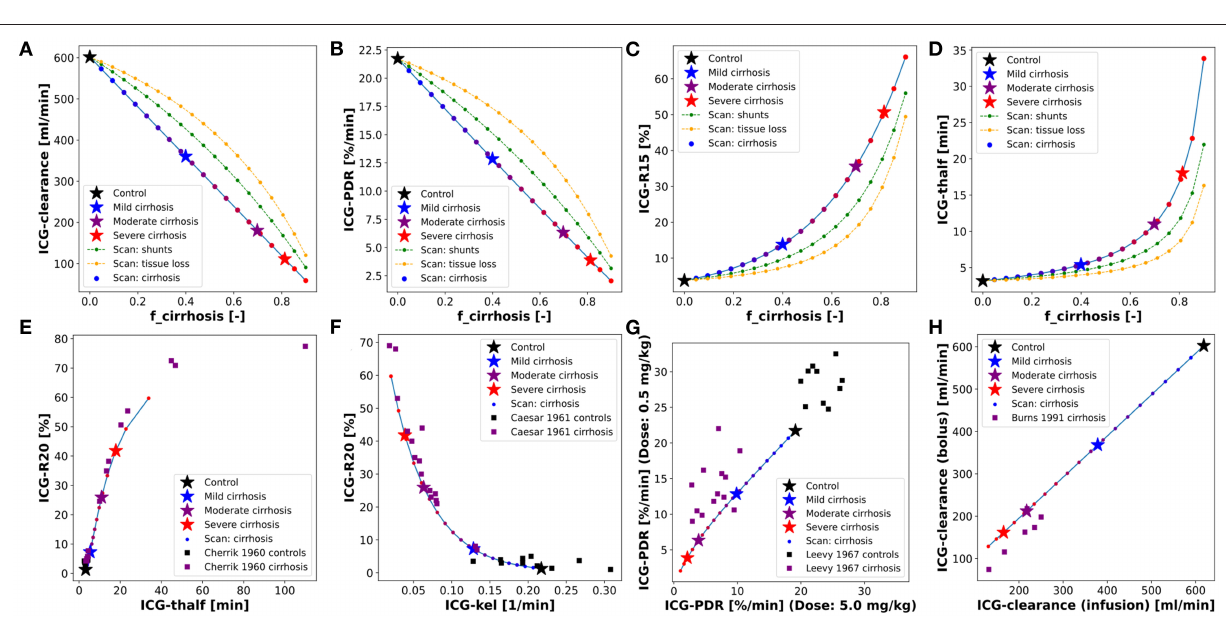
multiple datasets in which ICG pharmacokinetic parameters were reported in patient subgroups of different CTP-Scores (Figg et al., 1995; Møller et al., 1998, 2019; Herold et al.,